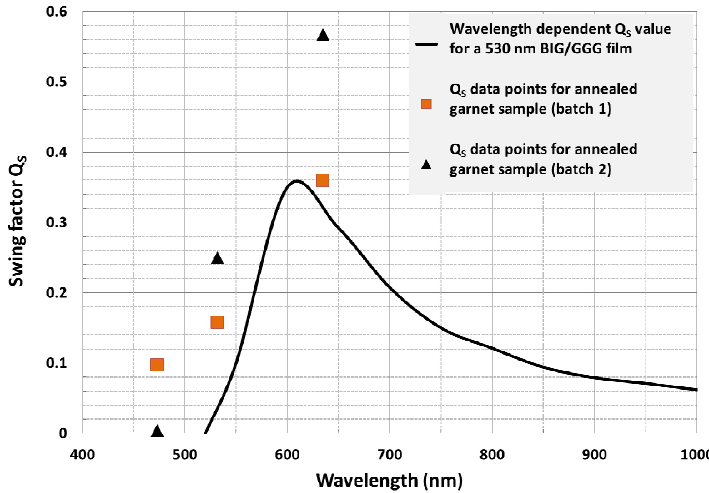
Figure 13. Measured swing factor of photo-response (Q S ) data points at 473 nm, 532 and 635 nm are presented against the Q S values of a 530 nm BIG/GGG film. The Q S values for the Bismuth iron garnet film (Bi 3 Fe 5 O 12 ) on Gadolinium Gallium garnet substrate ((Gd 3 Gd 5 O 12 ) (BIG/GGG) film are